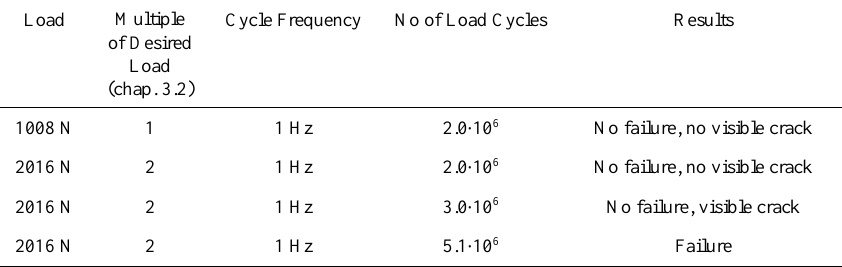
Table 5: Results of the fatigue tests with 100 mm x 100 mm component test